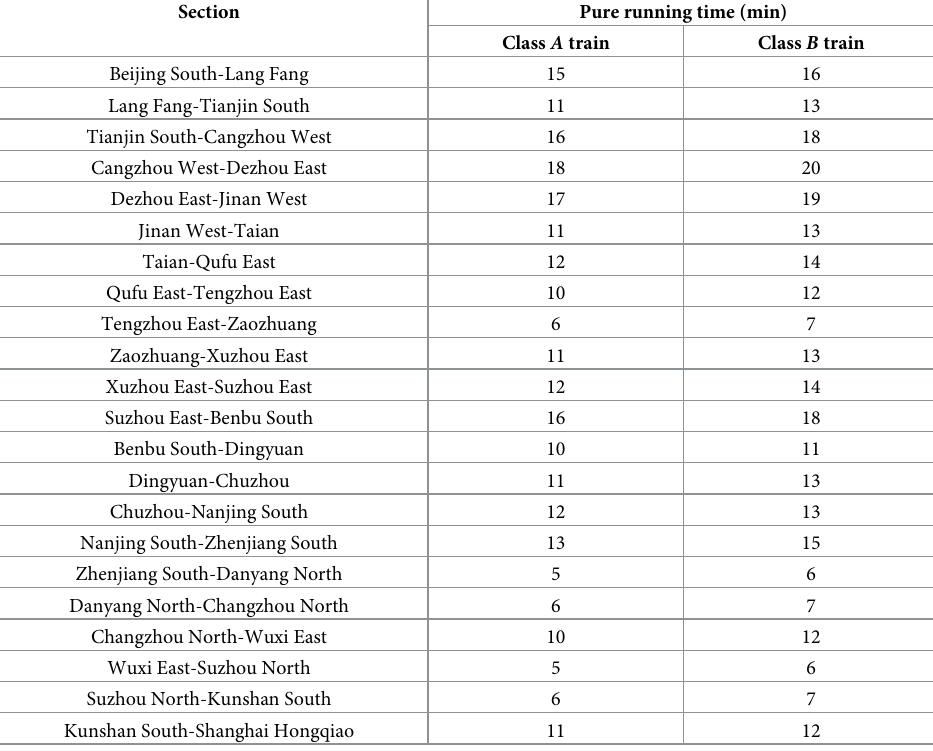
Table 7. Pure running time of trains in each section for both speed classes.